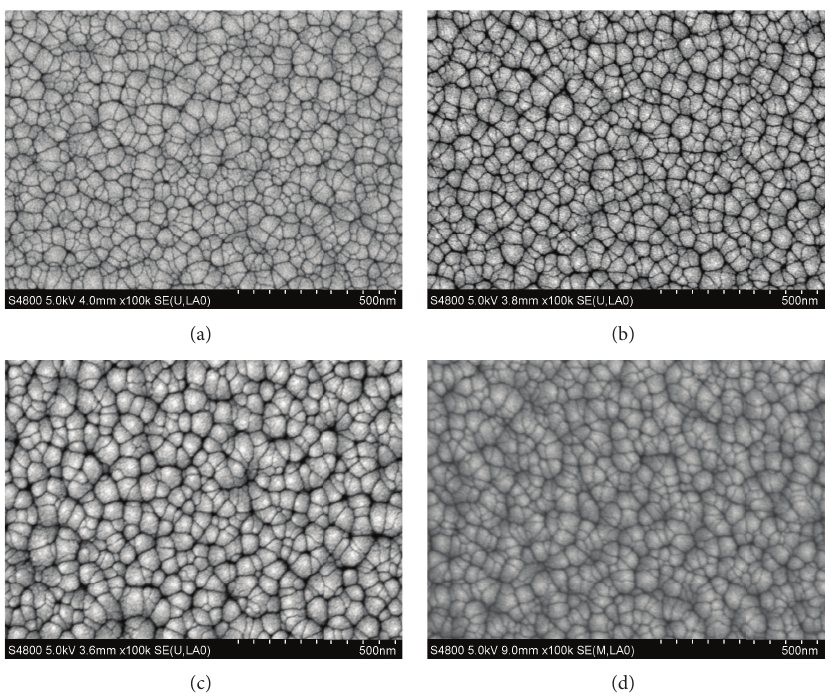
Figure 6: SEM images of ZnS films grown in various atmospheres. (a) 0.2P-Ar, (b) 0.2P-H, (c) 0.2P-2H, and (d)